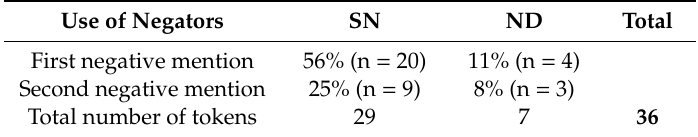
Table 3. Overall distribution (in absolute numbers and percentages) of ND and SN in the Sentence Completion Task, for participants exhibiting